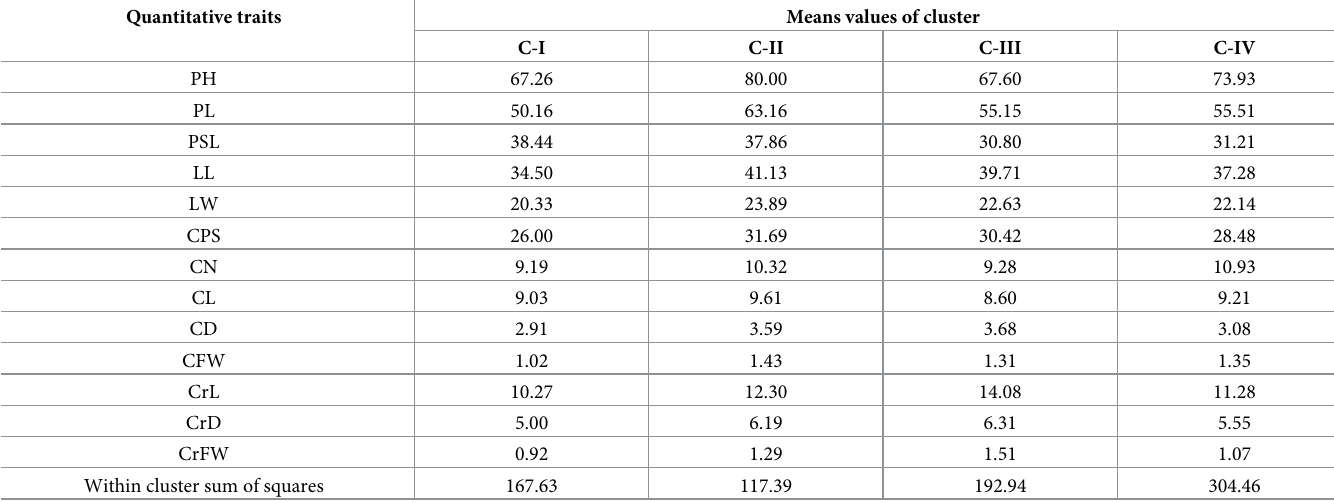
Within cluster sum of squares PH- plant height (cm), PL-petiole length (cm), PSL-petiole heath length (cm), LL-lamina length (cm), LW-lamina width (cm), CPS-circumference of pseudo-stem (cm), CN- cormel Number per plant, CL-cormel length (cm), Cormel Diameter (cm), CFW-cormel fresh weight per plant (kg), CrL-corm length (cm), CrD-corm diameter (cm) and CrFW-corm fresh